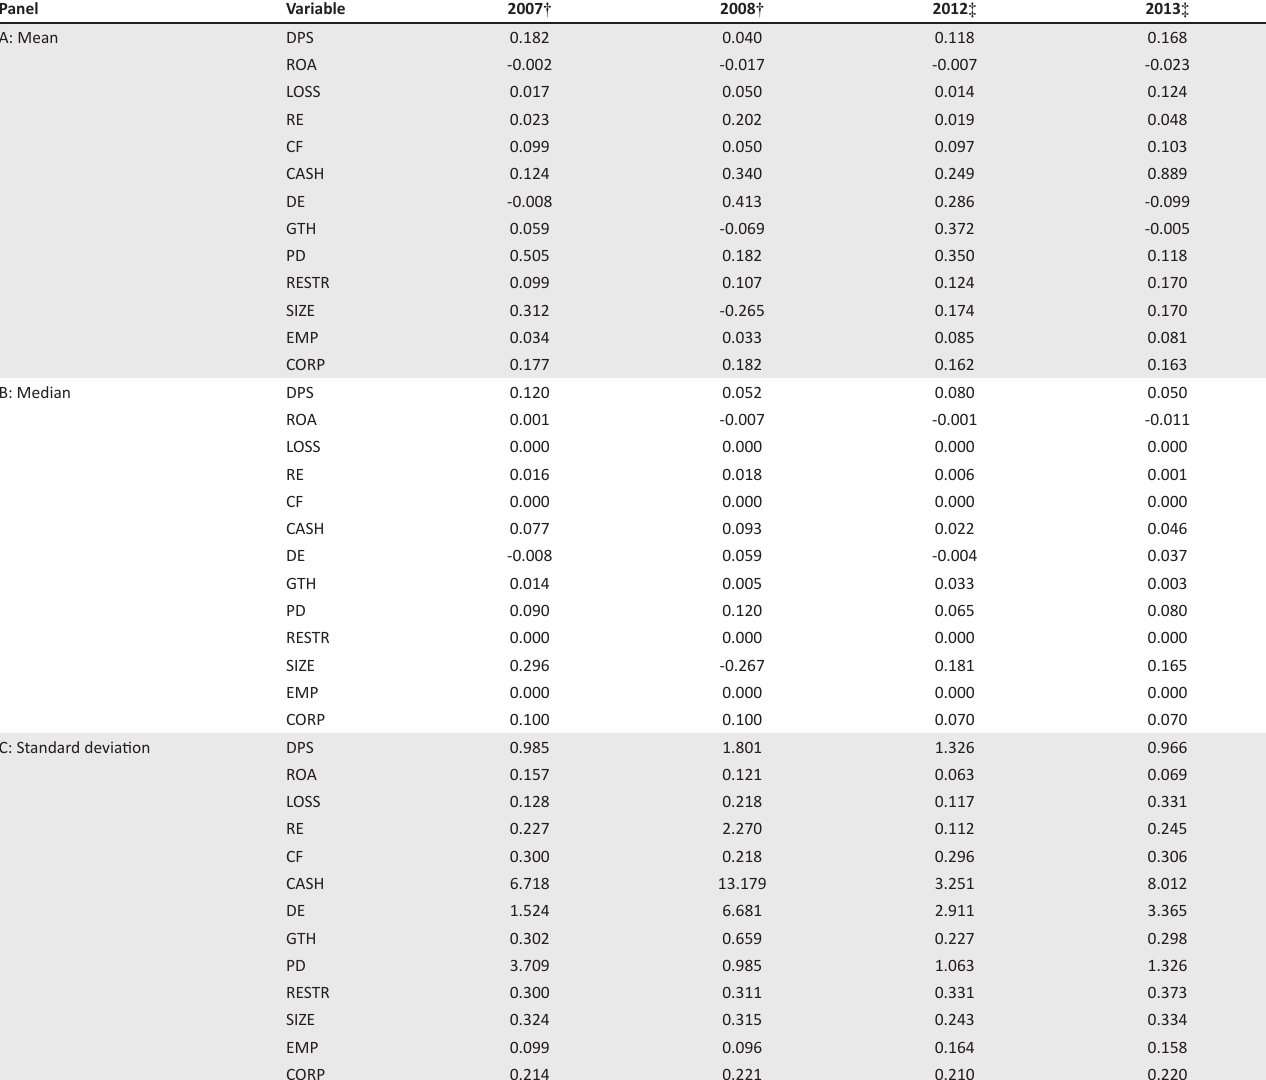
TABLE 2: Descriptive statistics. Panel